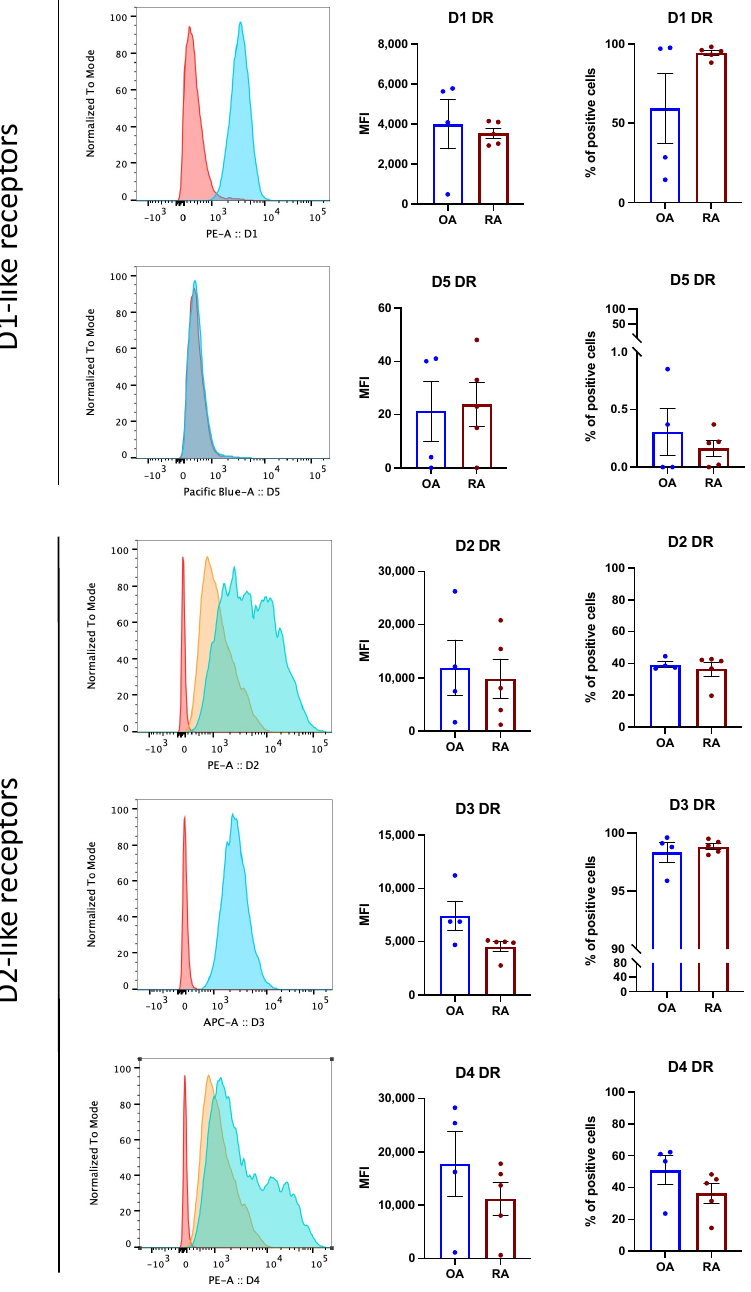
Figure 2. Primary osteoblasts express DR in vitro. Osteoblast were stained for DR by flow cytometry at passage 3. ( Left ): Representative histograms showing DR expression in RA. Red: unstained control; orange: secondary antibody alone (only for unconjugated primary antibodies); blue: specific DR staining. ( Right ): Mean fluorescence intensity (MFI) and % of positive DR stained cells in OA (blue bars) and RA (red bars). Histograms represent mean ± SEM. Each point represents one patient. OA n = 4, RA n = 5.